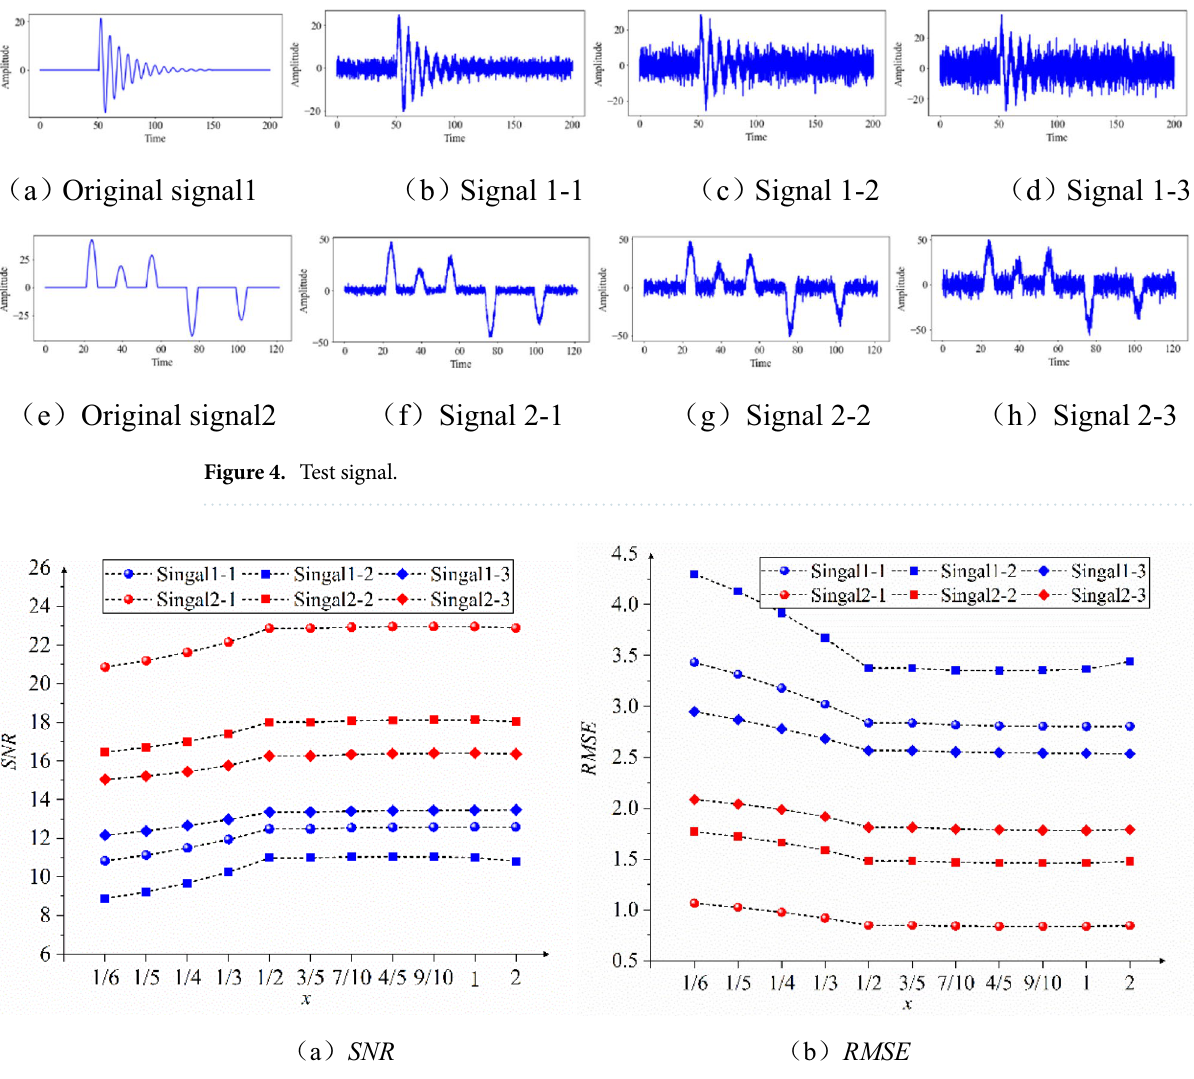
Figure 5. Variation trend of the SNR and RMSE of the denoised signal with different x